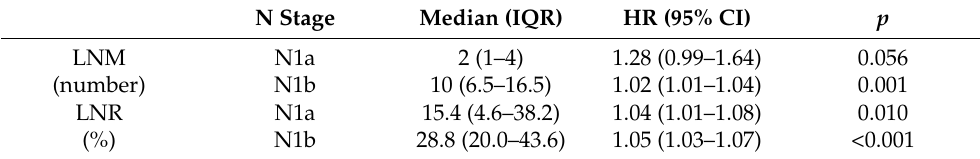
Table 3. Comparison of LNM and LNR based on N